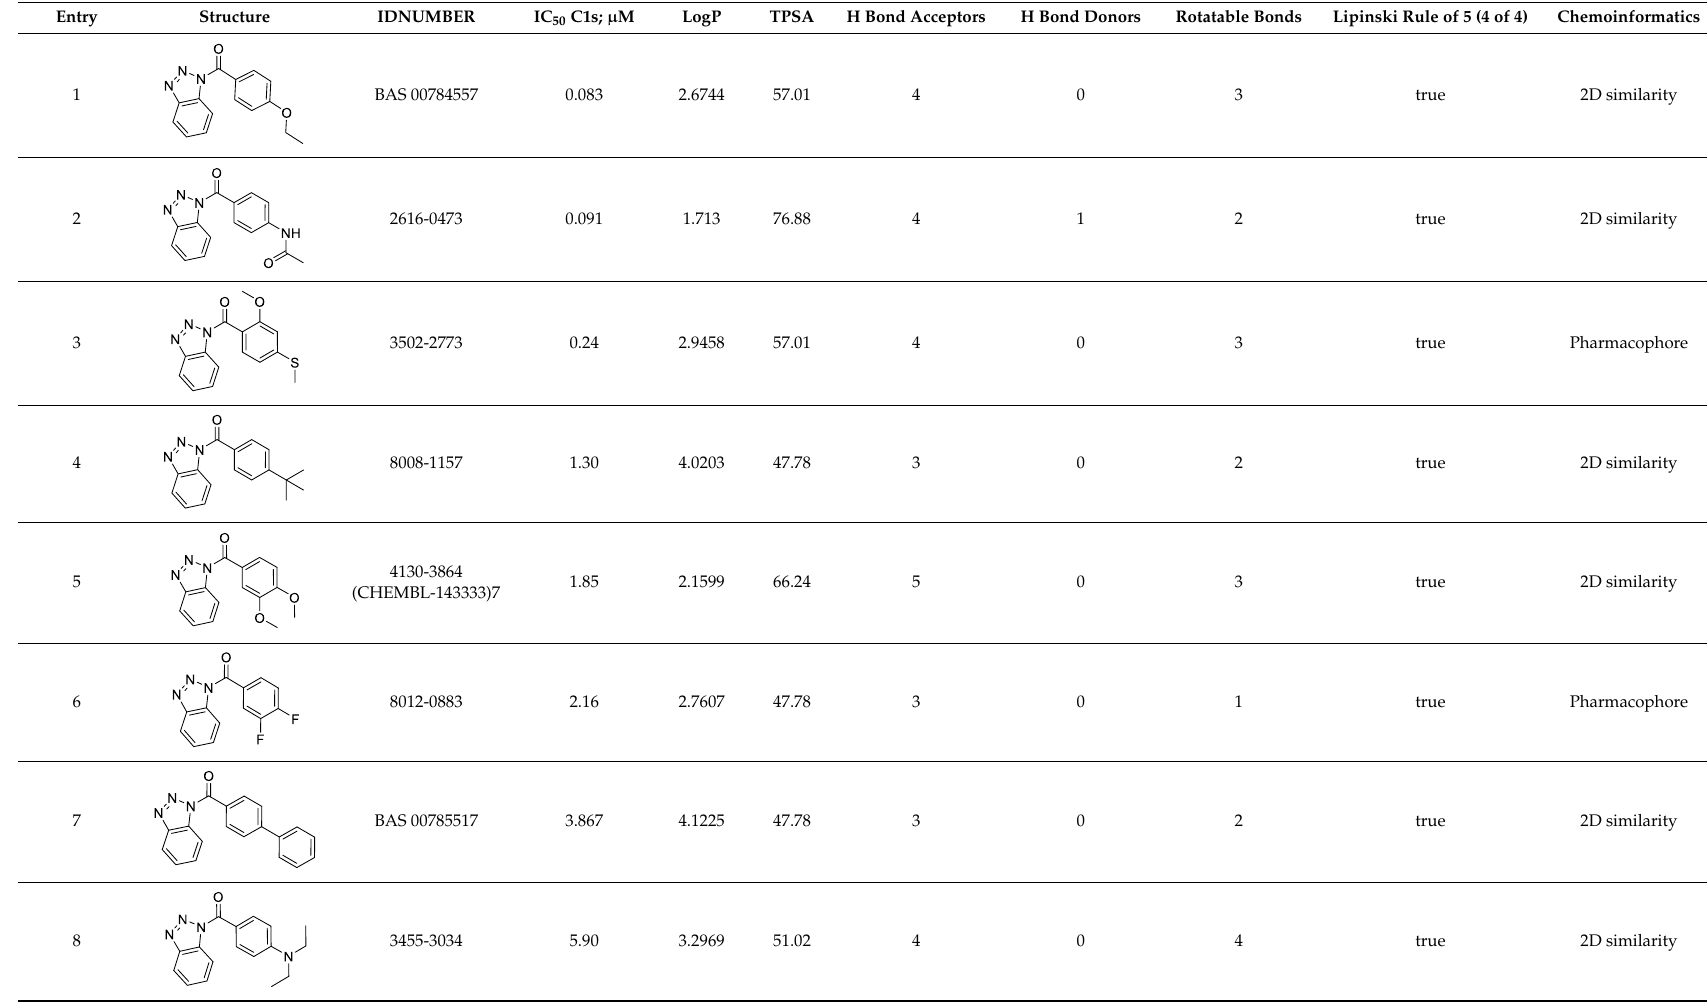
Table 1. Hit compounds derived from the 1,2,3-benzotriazole chemotype. We considered hits if the inhibitory activity was < 10 µ M. In some cases we display compounds with weak activities ( ≤ 50 µ M; in italics ).